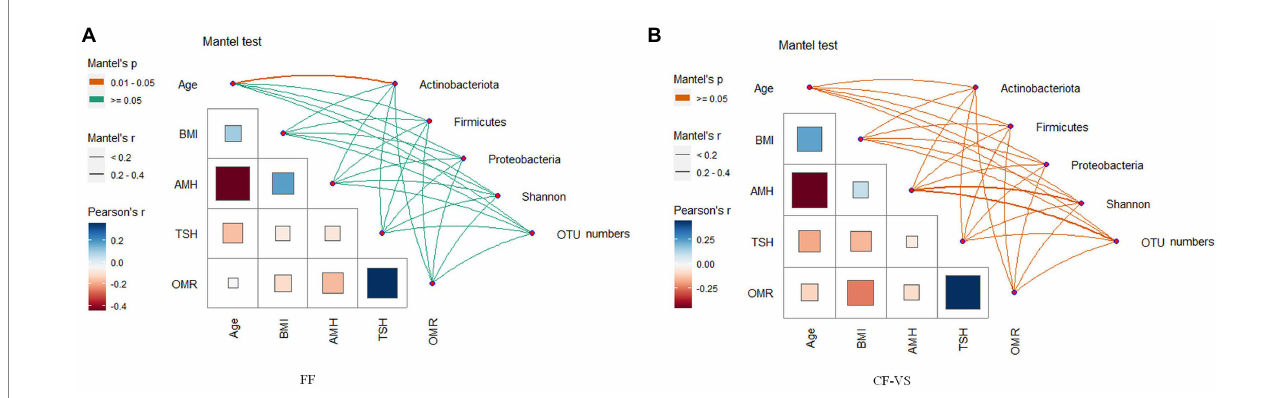
FIGURE 10 Paired comparison of environmental factors and microbial community. (A) Correlation analysis of phylum level microorganisms and diversity with environmental factors in follicular fluid, (B) Analysis on the correlation between environmental factors and microbial diversity at the level of cervix and vagina. The color of the line indicates the size of the significance p value of the Mantel test, and the thickness indicates the size of the correlation, FF, Follicular fluid; CF - VS , Cervical fluid – Vaginal